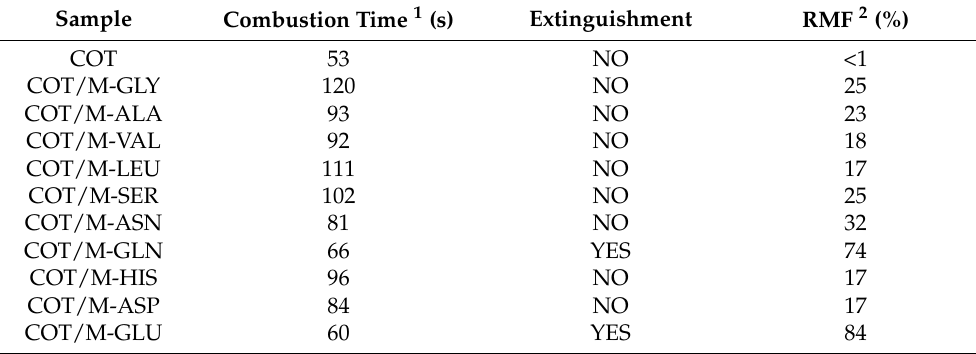
Figure 8. Snapshots of the residues of 5% add-on, PAA-treated cotton samples after undergoing HFSTs. The PAA structures are reported in Table 2. Table 7. Combustion data of untreated and PAA-treated cotton fabrics with 5% add-on obtained from